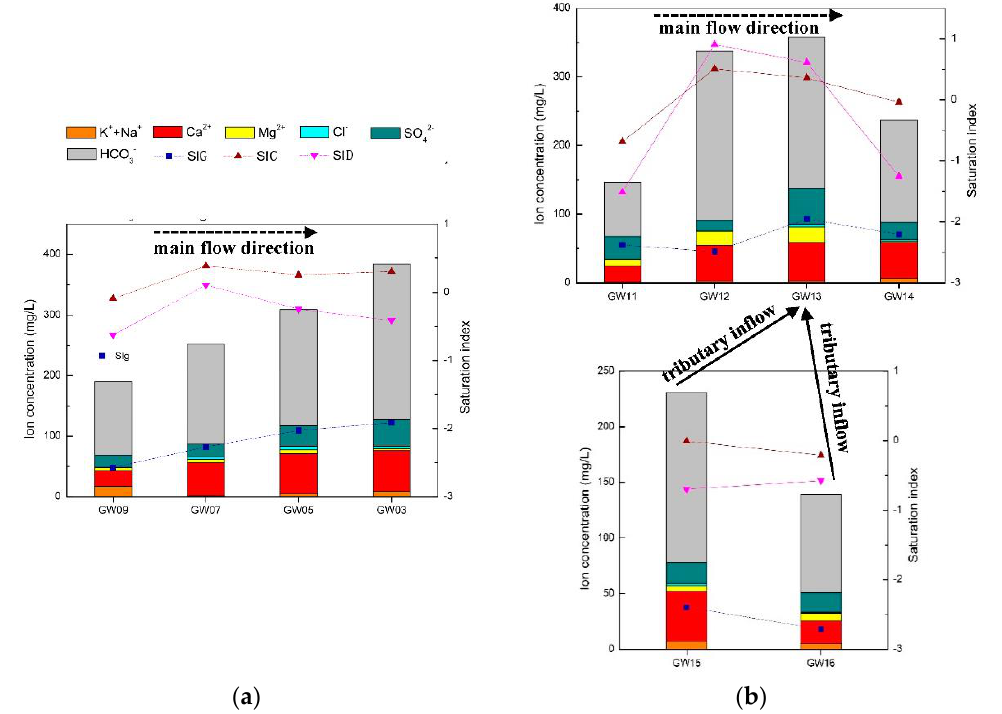
Figure 8. ( a ) North karst system hydrochemistry variation along the main conduit; ( b ) FWS karst system hydrochemistry variation along the main conduit and the influence of tributaries.